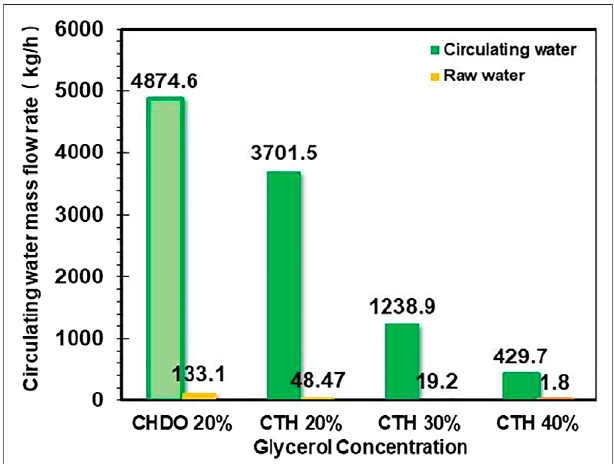
FIGURE 6 | In fl uence of glycerol concentration in aqueous feed on product fl ow and distribution.